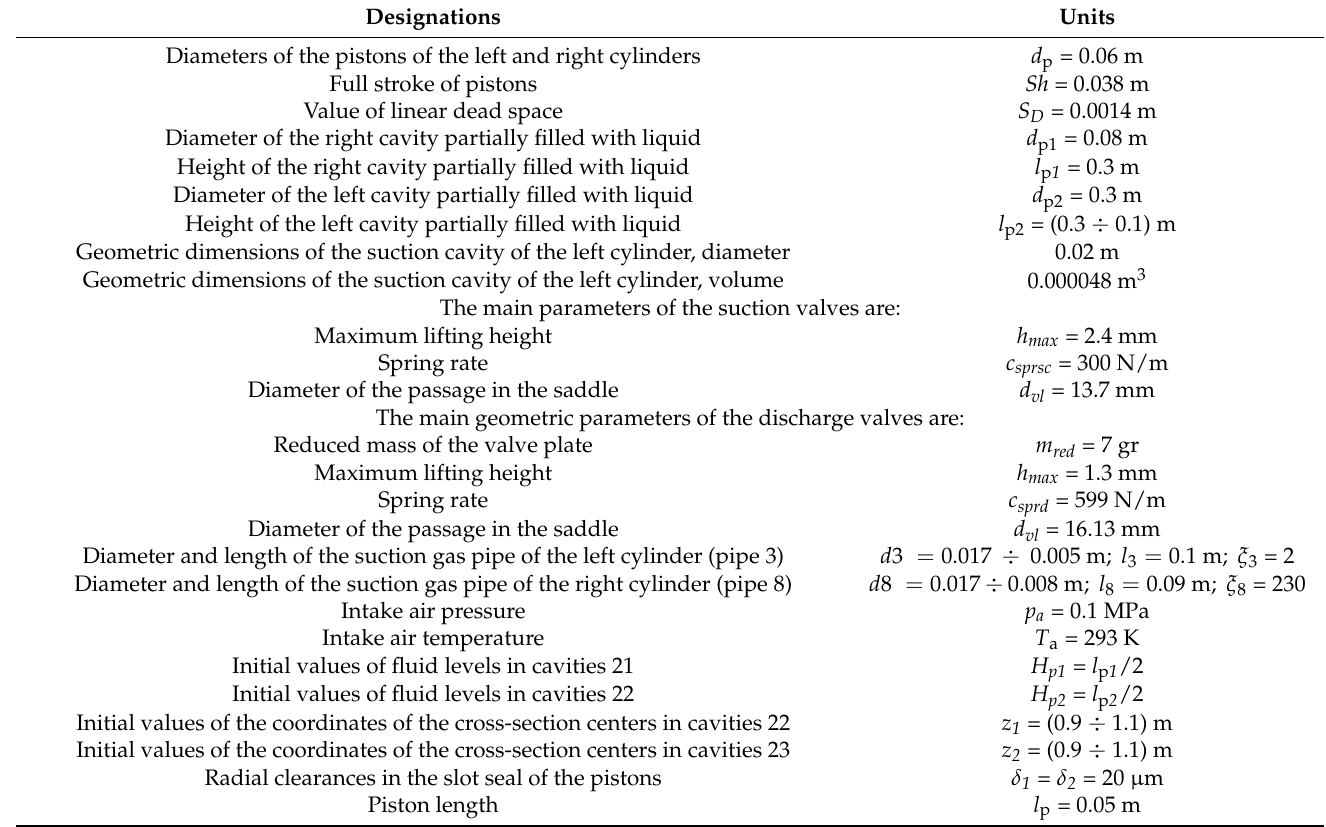
Table 5. Compressor and cooling system